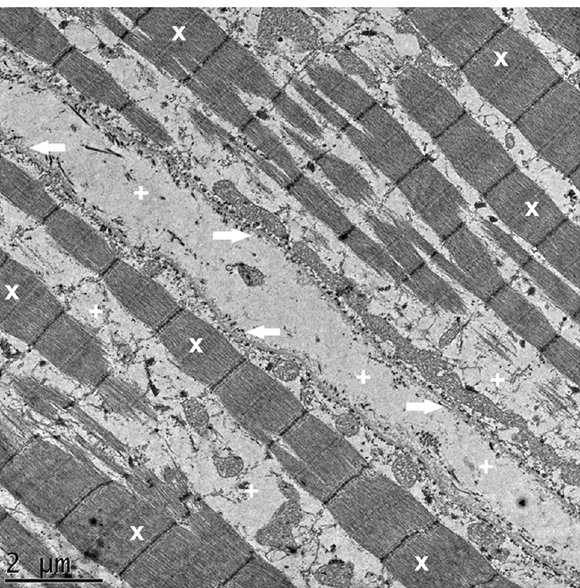
Figure 4. Group1 (G1, stretched to 20%). Stretch G1 TEM image demonstrating preservation of majority of sarcomers and identifiable myofibrillar structure (X); however, the distance between the myofibrils, and the cells is increased (+), with the cell membrane still attached to the intracellular structures